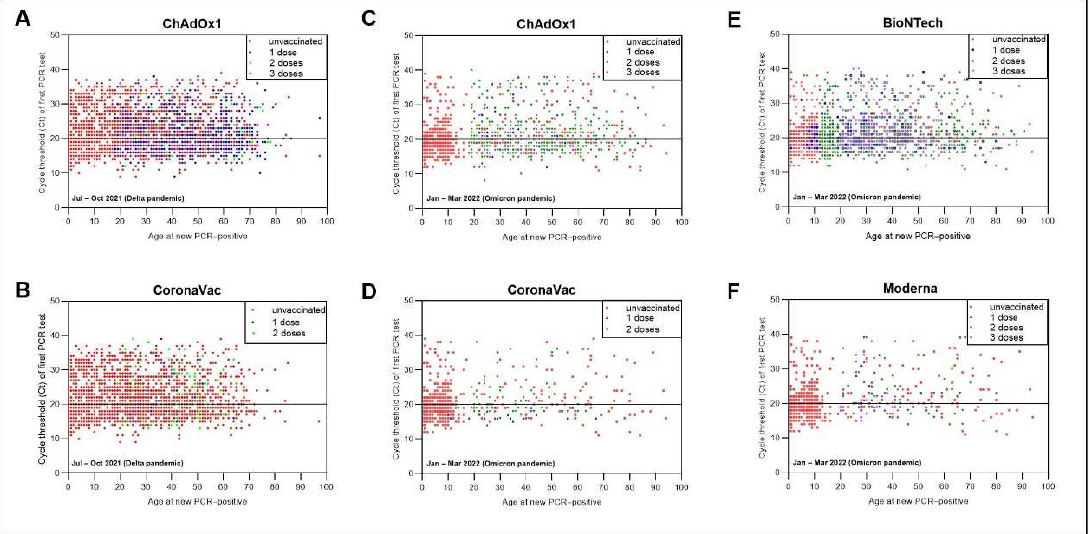
Figure 3. Ct value trajectories of confirmed COVID-19 infection and symptoms during the Delta ( A , B ) and Omicron ( C – F ) pandemics in vaccinated and unvaccinated individuals. Ct values in PCR-positives after receiving ChAdOx1 or CoronaVac or BioNTech or Moderna vaccines or unvaccinated, regardless of vaccine doses by time since July 2021. Red dots are represented in all figures as reference values.